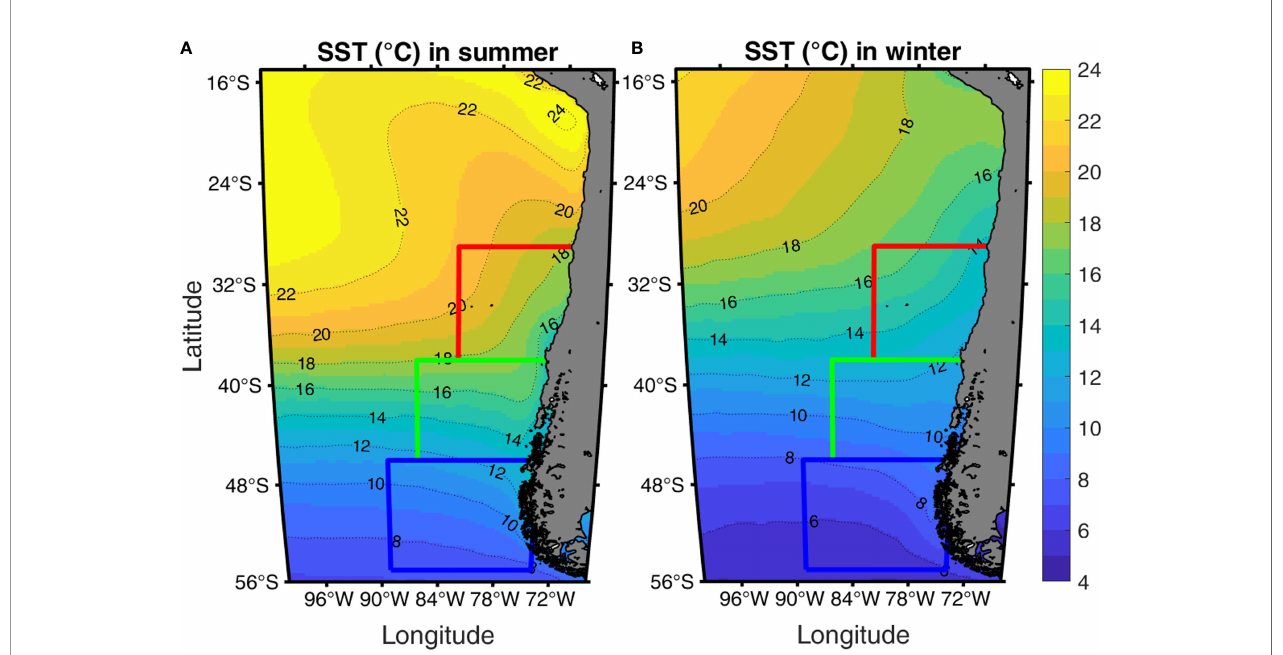
FIGURE 1 | Mean sea surface temperature (SST; °C) in Southeast Paci fi c during summer (A) and winter (B) . Seasonal averaged SST has been calculated over 1982-2020. Studied areas are indicated by the coloured squares: in red the Northern area (-82°E to -71°E and 38°S to 29°S); in green the Transition area (-86°E to -72°E and 46°S to 38°S); in blue the Southern area (-89°E to -74°E and 55°S to